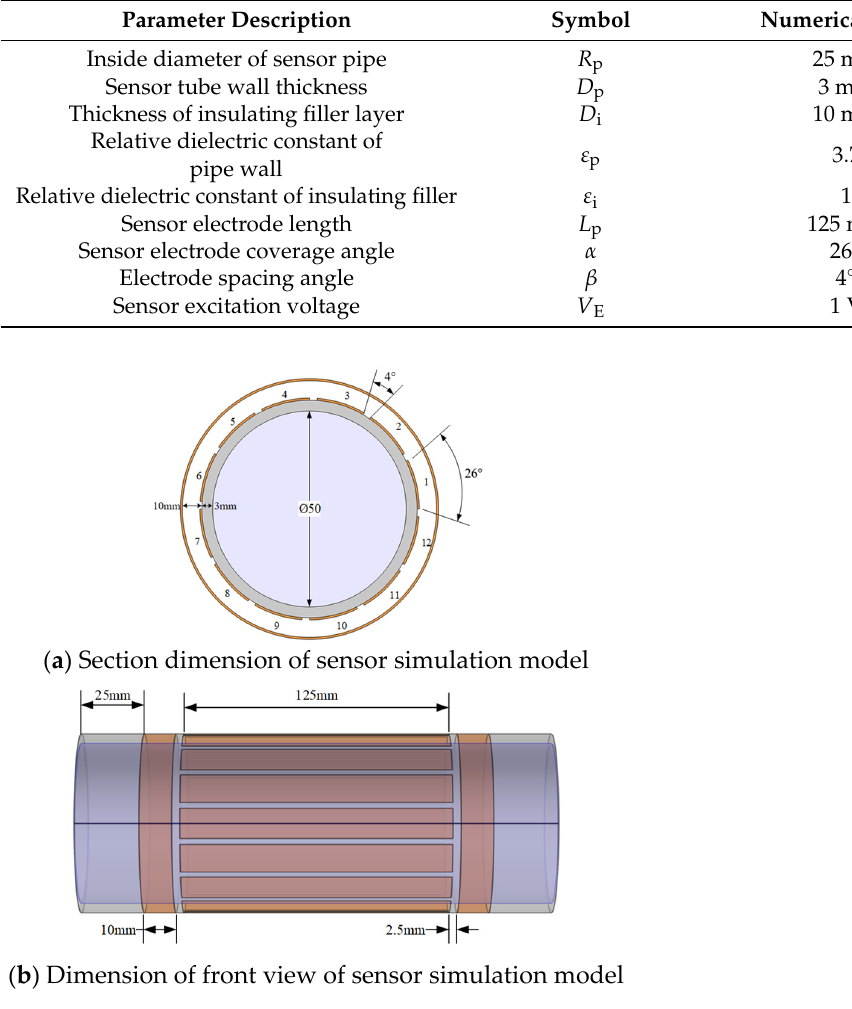
Figure 3. Schematic diagram of geometric parameters of sensor simulation model.